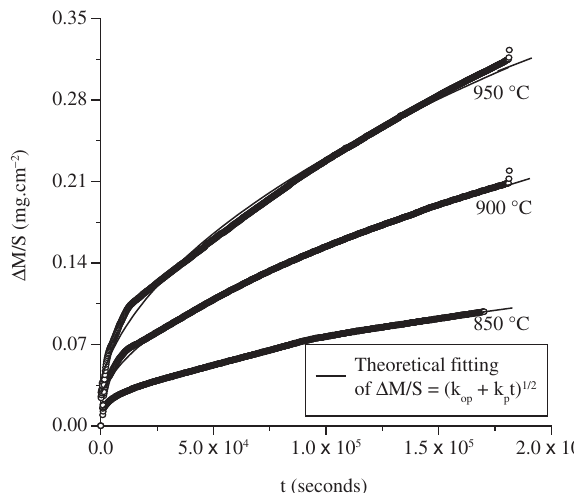
Figure 2. Thermogravimetric analysis for the oxidation of the 430E steel in Ar/H